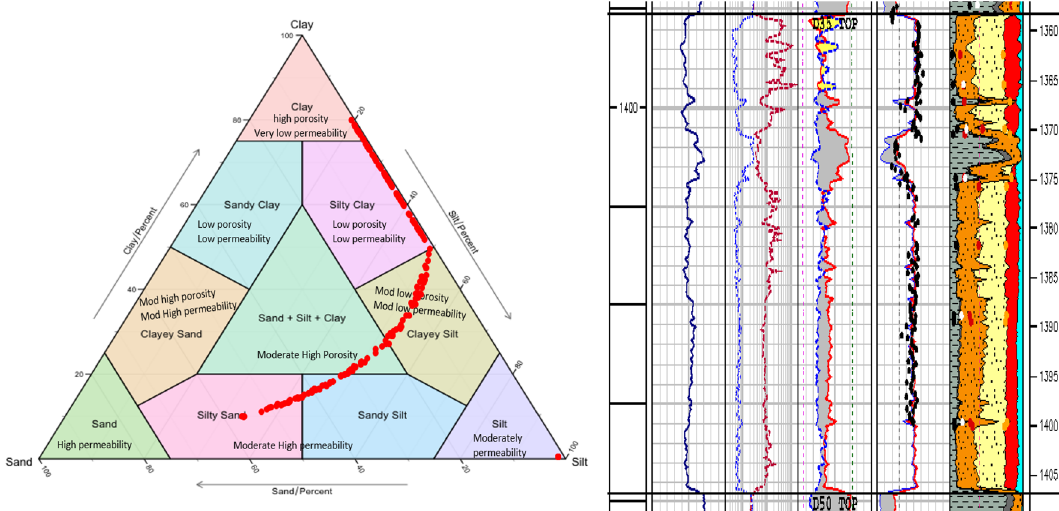
Fig. 12 Ternary diagram for the cored interval in the study